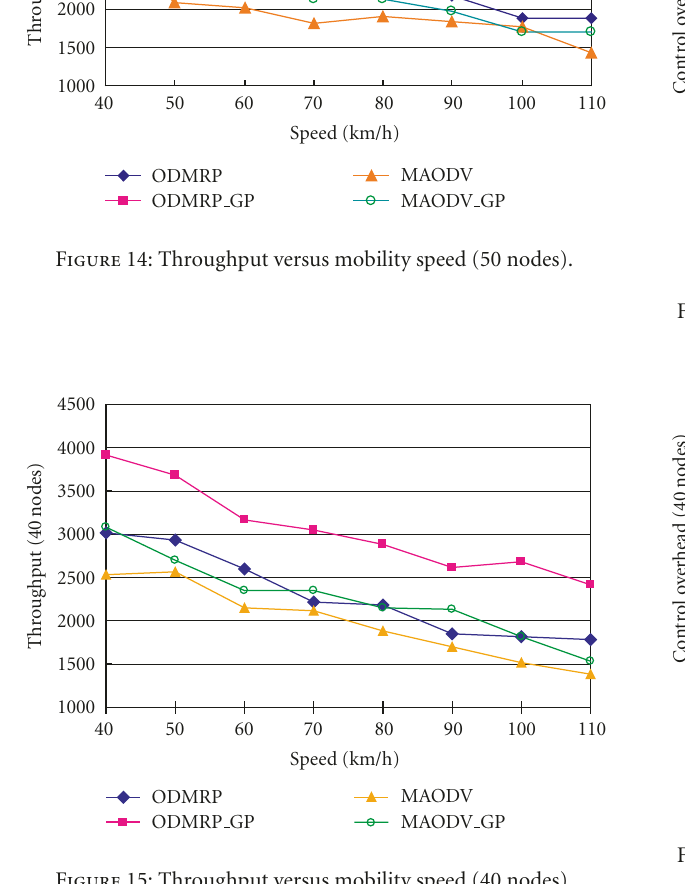
Figure 15: Throughput versus mobility speed (40 nodes).